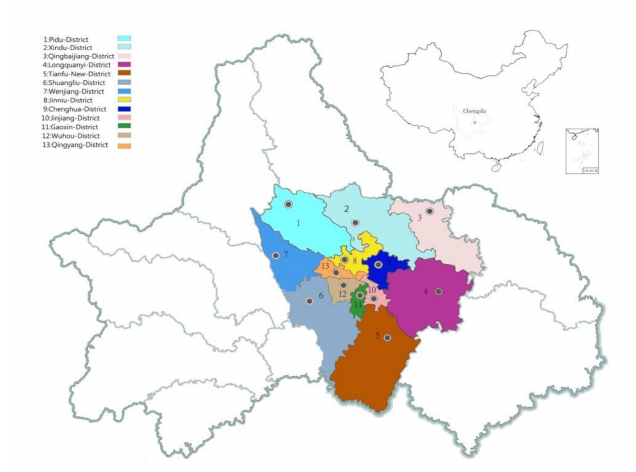
Figure 5. Sampling administrative district of neighborhood communities in Chengdu. Table 1. Social demographic features of participants ( N =